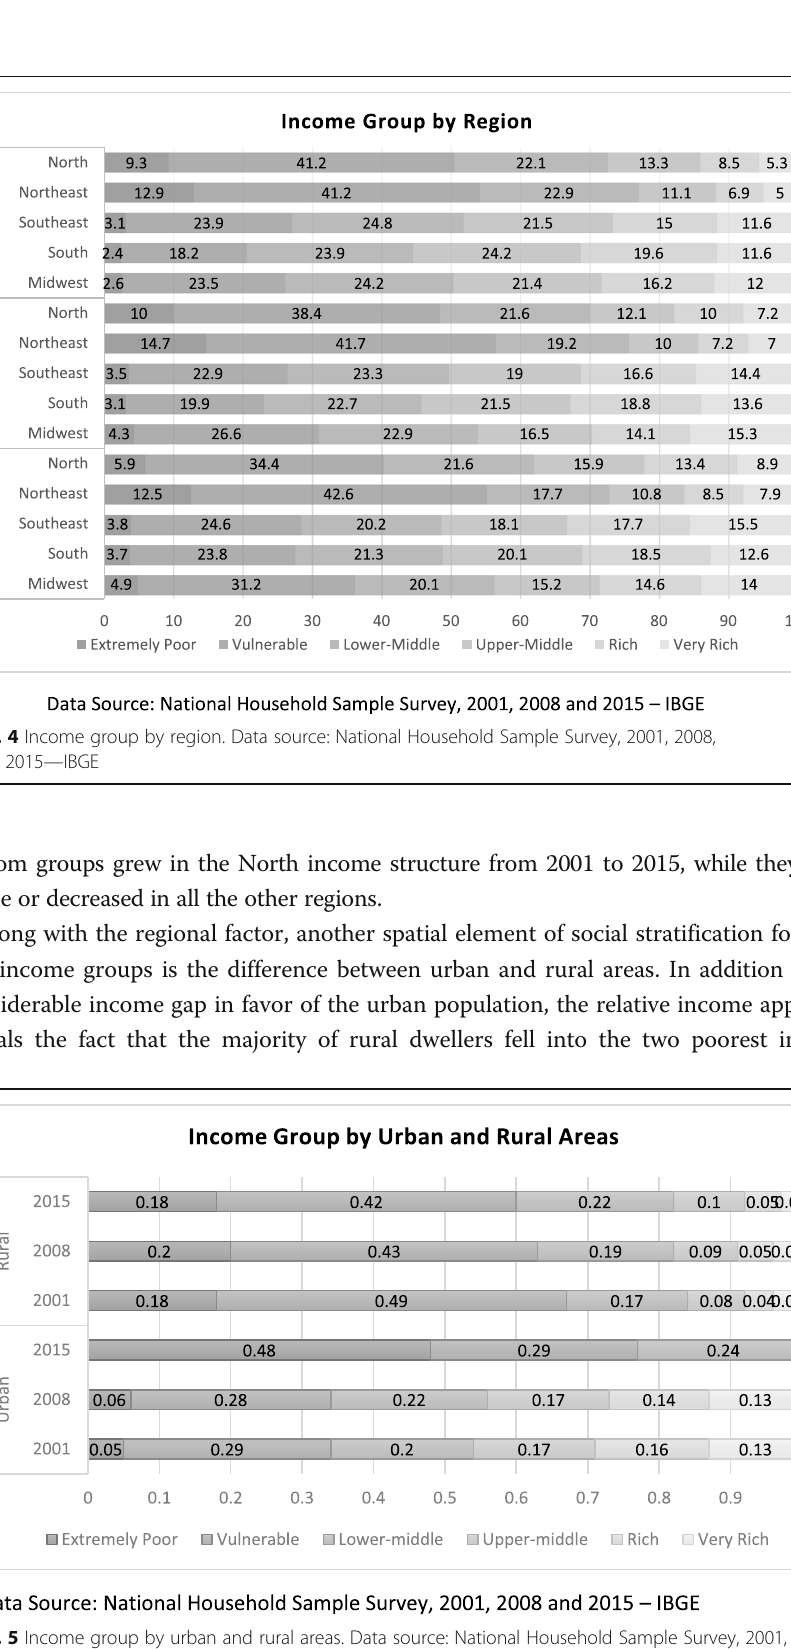
Fig. 5 Income group by urban and rural areas. Data source: National Household Sample Survey, 2001, 2008, and 2015 —